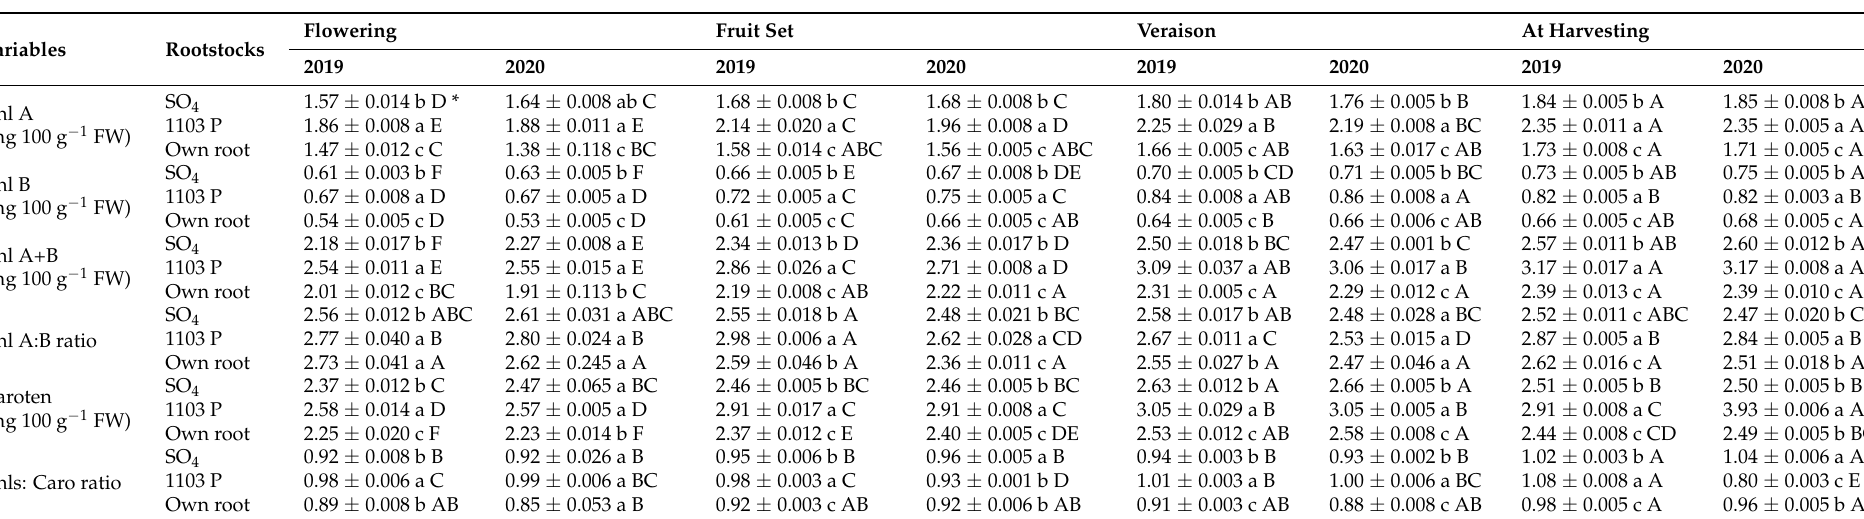
* The mean and standard error of the mean are used to represent the data. Tukey-HSD test at p < 0.05 for mean separation among columns (lowercase letters) and rows (uppercase letters). Data were obtained at various stages of berry growth. Table 2. The effect of rootstocks (SO 4 , 1103 Paulson, and own root) on photosynthetic pigments was assessed four times during two growth seasons (2018–2019) on various berry developmental phases (flowering, fruit set, veraison, and at harvest time) of “superior seedless”